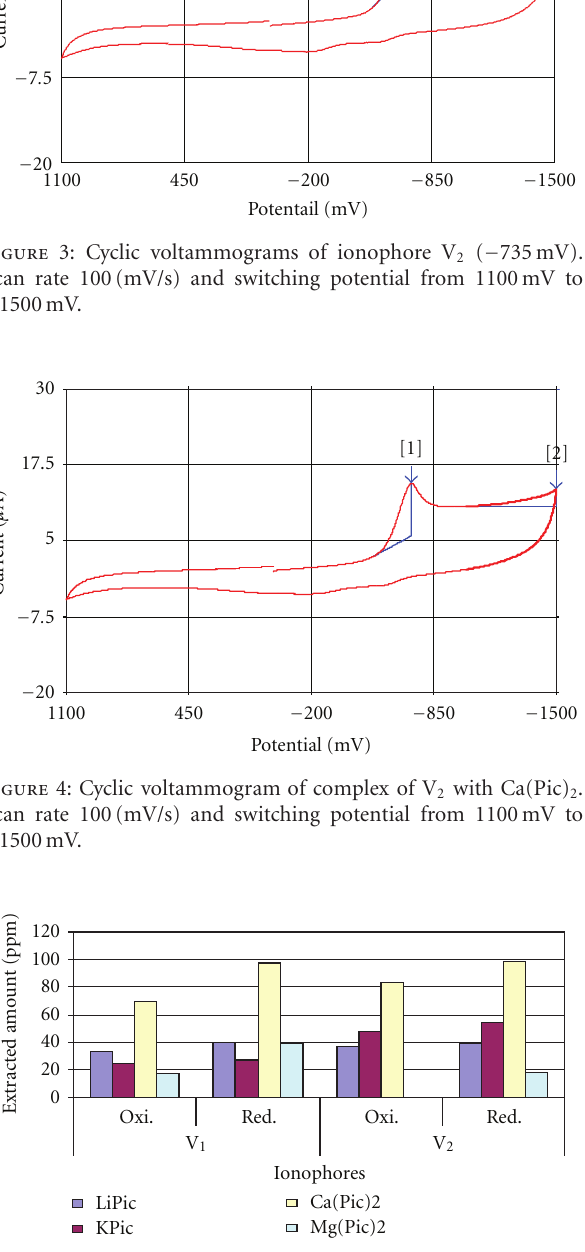
Figure 5: Extraction of metal ions using ionophores V 1 and V 2 .